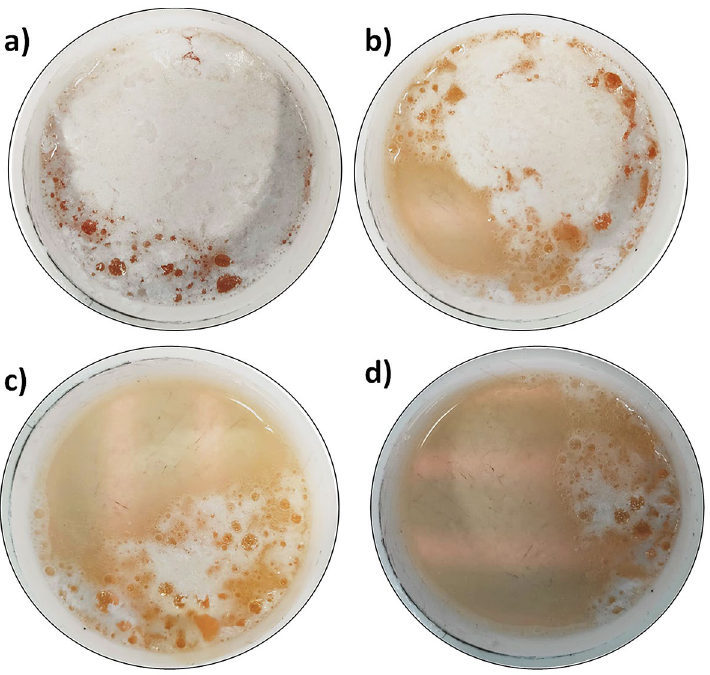
Figure 2. NF sample with 1 wt% of NPs at different temperatures, from 300 °C ( a ) to 450 °C ( d ). It is evident the formation of the foamy-like white semisolid layer on top of the sample that is colder than the liquid phase as it can be seen in Fig. 1, left hand side of images (15) to